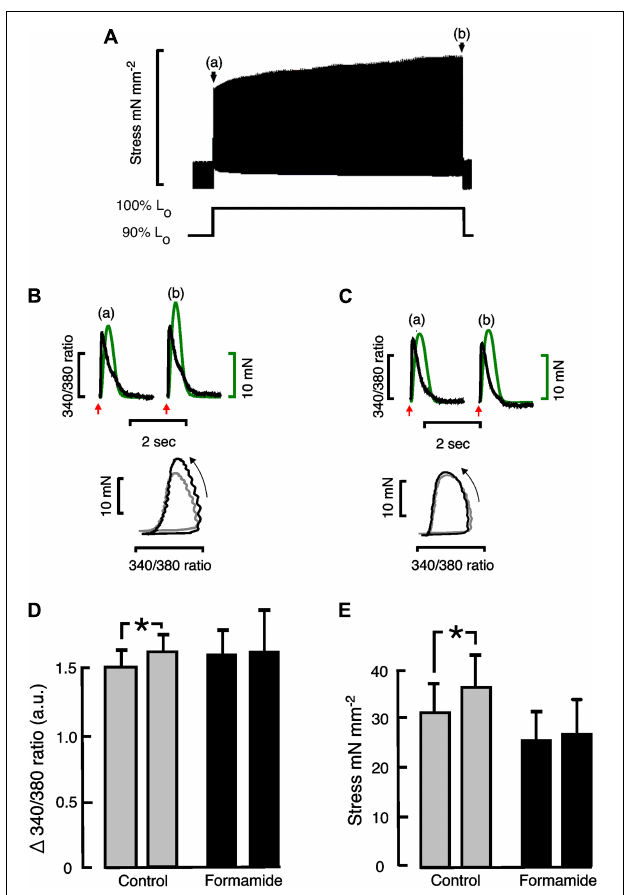
FIGURE 2 | Effect of formamide on slow force response to stretch. (A) Shows a representative slow force response from a rat trabecula stretched from 90 to 100% L o . (B) (Control) and (C) (formamide) show Ca 2 + transients (black) and twitch force (green) immediately after stretching a representative trabecula from 90 to 100% L o on left (a), and after 3 min at 100% L o on right (b). Red arrows indicate the time of stimulation. Phase plots of the force vs. Ca 2 + data are shown beneath the Ca 2 + transients and twitches with arrows indicating the direction of time. Phase plots immediately after the stretch are shown in gray, and after 3 min at 100% L o are shown in black. (D) Shows mean ± SEM Ca 2 + transient amplitudes ( n = 4), and (E) shows mean ± SEM stress ( n = 6) immediately after stretching trabeculae on left, and after 3 min at 100% L o on right, for control (gray bars) and formamide treated (black bars) trabeculae. * P < 0.05. Two-tailed paired t -test. a.u, Arbitrary units.